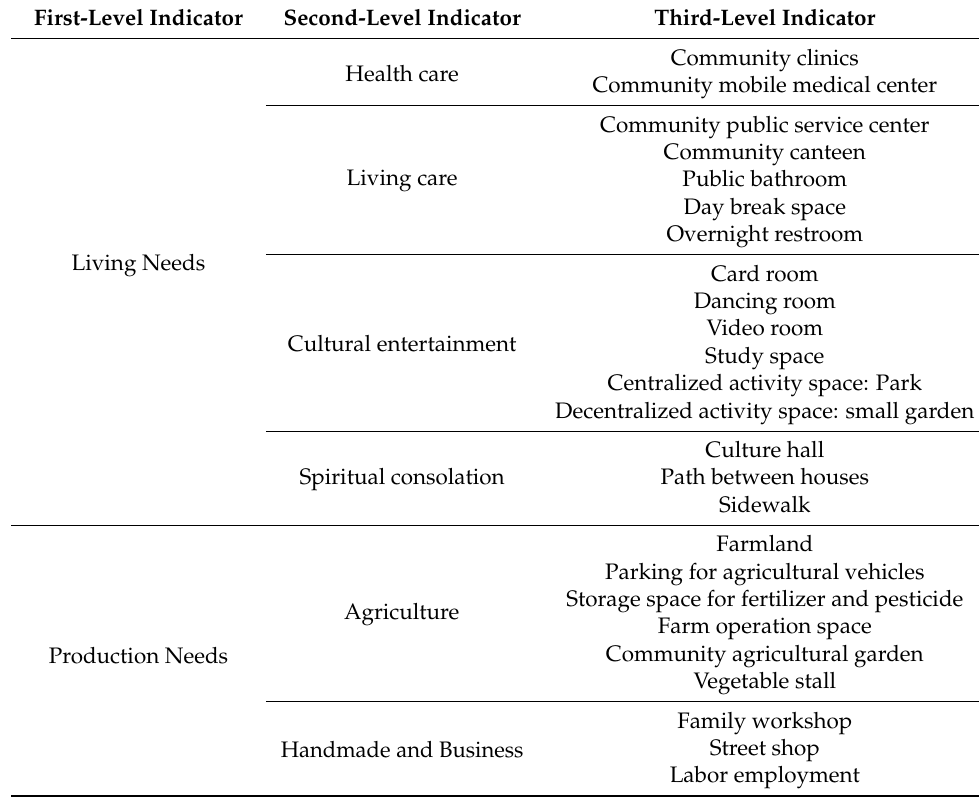
Table 1. Production- and living-needs indicator